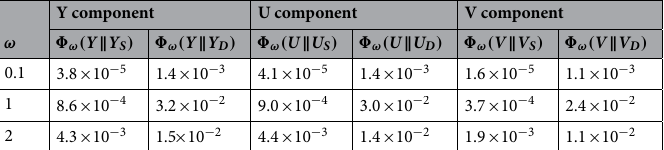
Table 4. Message importance measure loss. The experimental results are obtained on the DRIVE